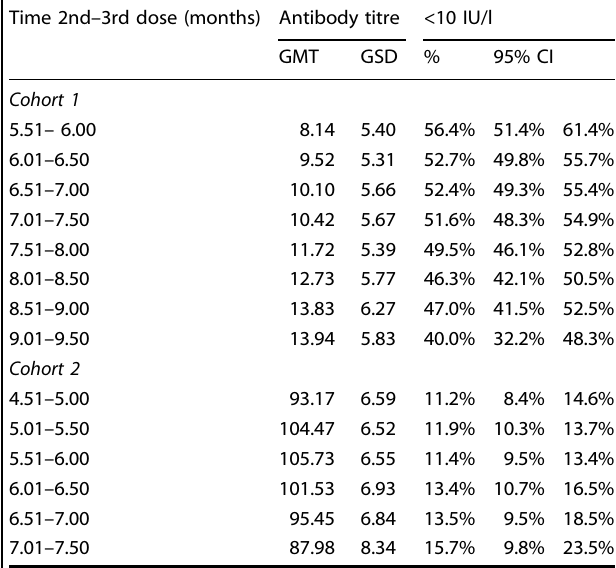
Table 4. Long-term anti-HBs titre and proportion of individuals below 10 IU/l by time interval between the administration of the second and the third